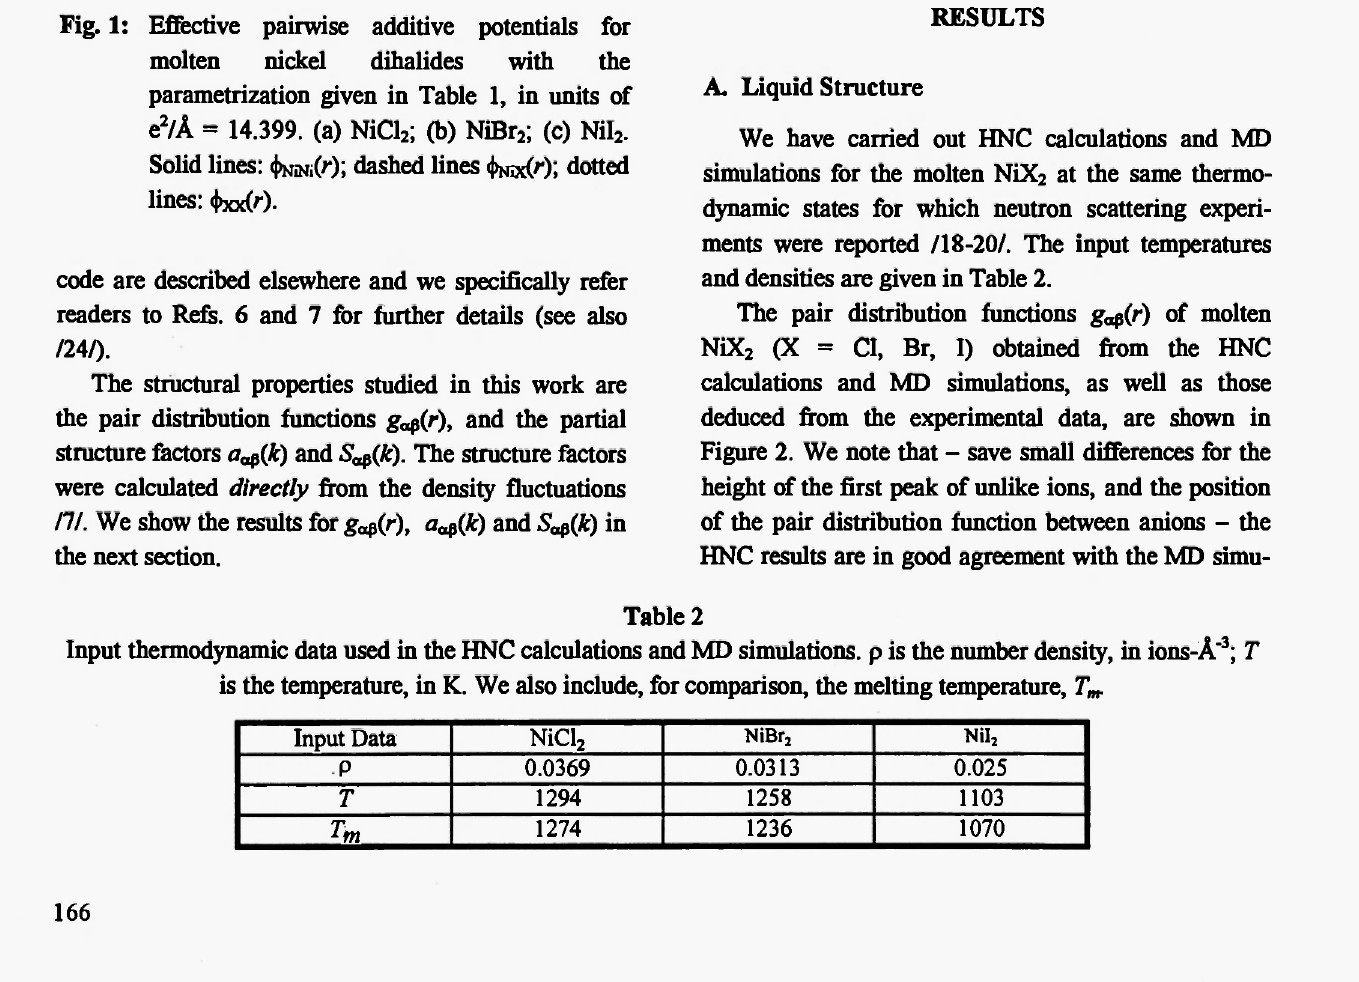
Fig. 1: Effective pairwise additive potentials for molten nickel dihalides with the parametrization given in Table 1, in units of e 2 /Ä = 14.399. (a) NiCl Solid lines: ΦνμΜ; dashed lines <t>Nix{r); dotted lines: φχχ(/·).